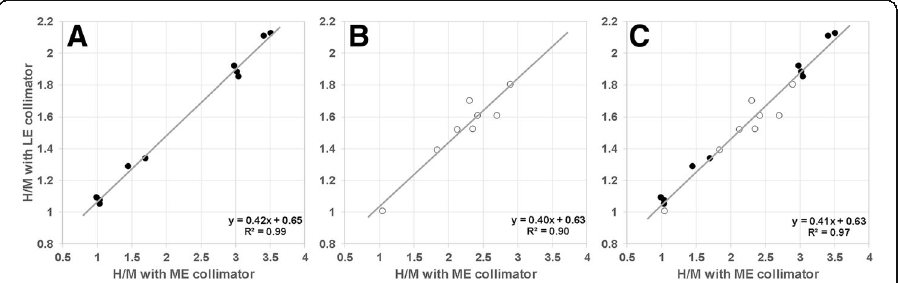
Fig. 1 Scatter plots and linear regression analyses between the MIBG heart-to-mediastinum ratio (H/M) acquired with low-energy collimators (LE) in comparison to the H/M ratio obtained with medium-energy collimators (ME). Plots are given separately for each center ( a , Freiburg; b , Würzburg) and pooled together ( c ). Closed circles indicate subjects from center a , and open circles indicate those from center